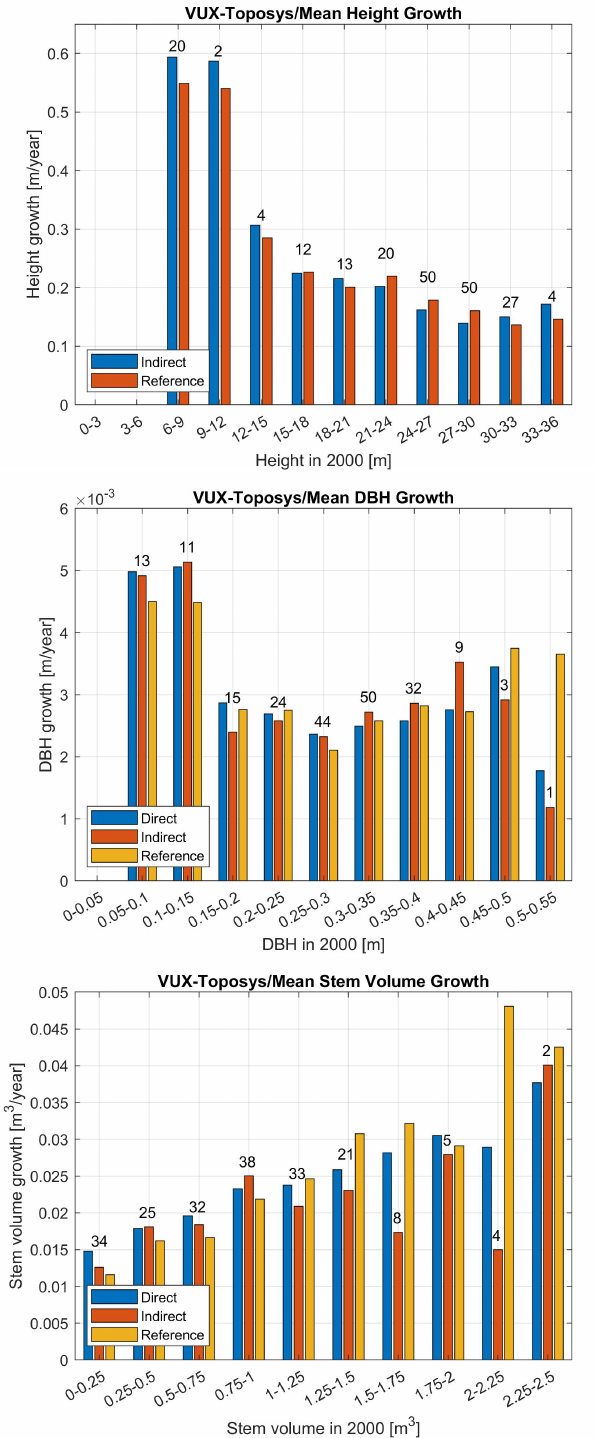
Figure 8. Mean growth values per attribute interval. The number on top of the bars is the number of samples in that